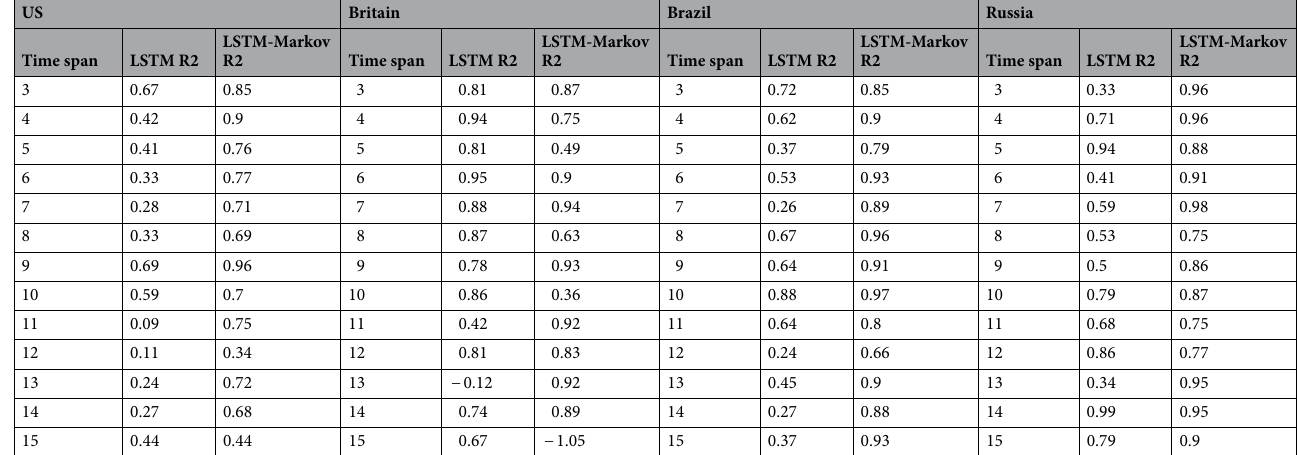
Table 2. The model’s R2 of different time step.